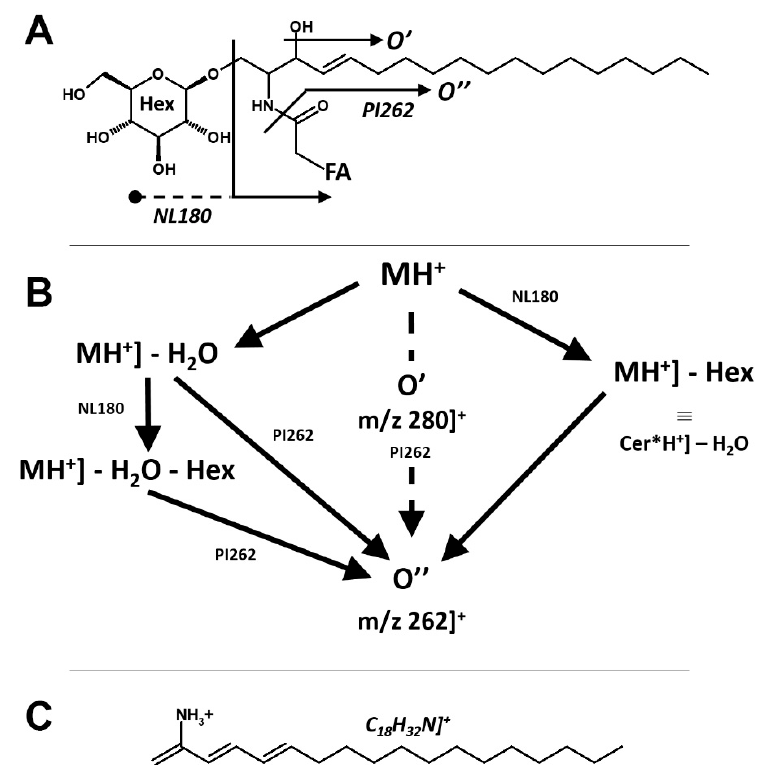
Figure 3. Overall fragmentation pattern of protonated hexosyl-ceramides, exemplified for those with the “standard” 1,3-dihydroxy-C-18:1 long chain base. Panel ( A ): correspondence of fragments to motifs in the molecular structure. Panel ( B ): development of decomposition processes and triple quadrupole scan experiments used to highlight individual molecules from their fragmentation. Panel ( C ): formal connectivity of the ceramide pivot fragment O’’.